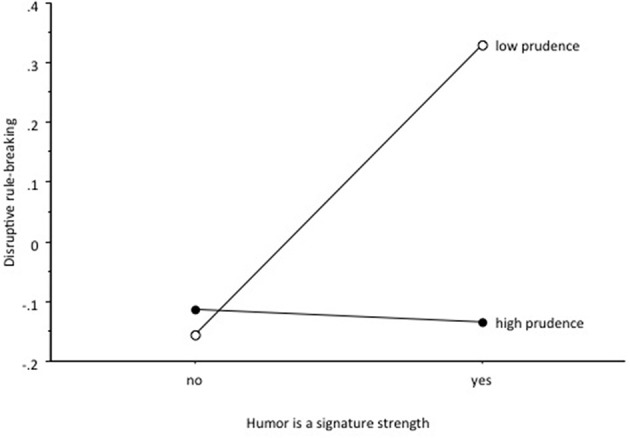
Interactive effects of humor as a signature strengths (yes, no) and prudence (high, low) on the degree of disruptive rule-breaking.